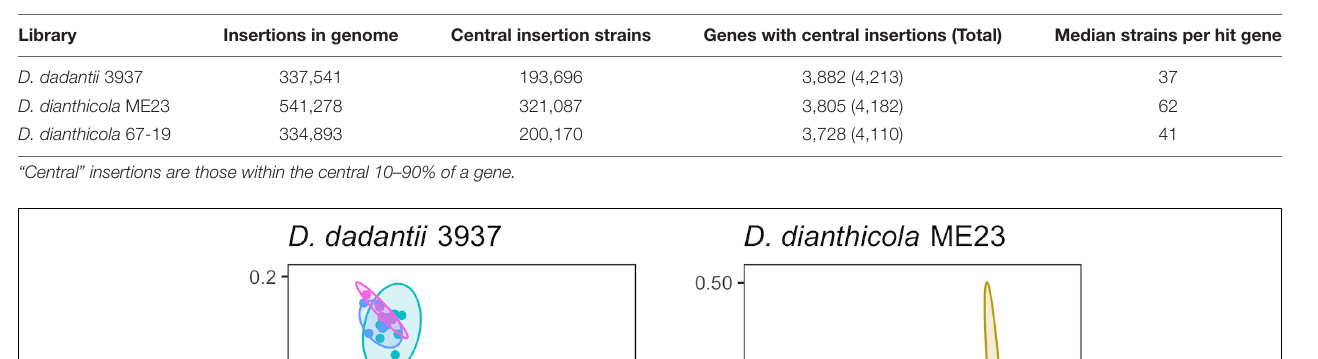
Frontiers in Microbiology |